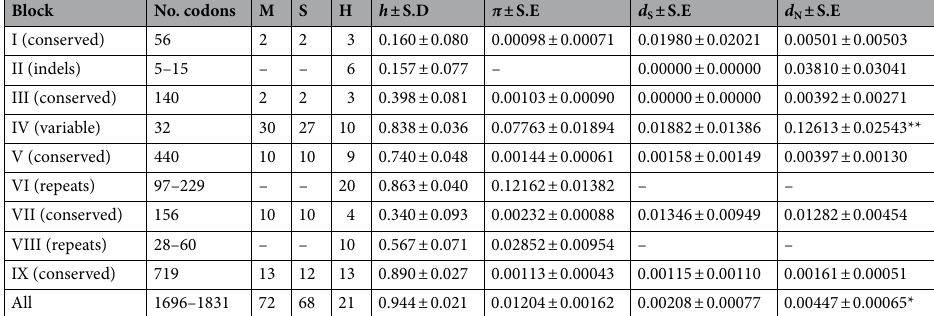
Block No. codons M